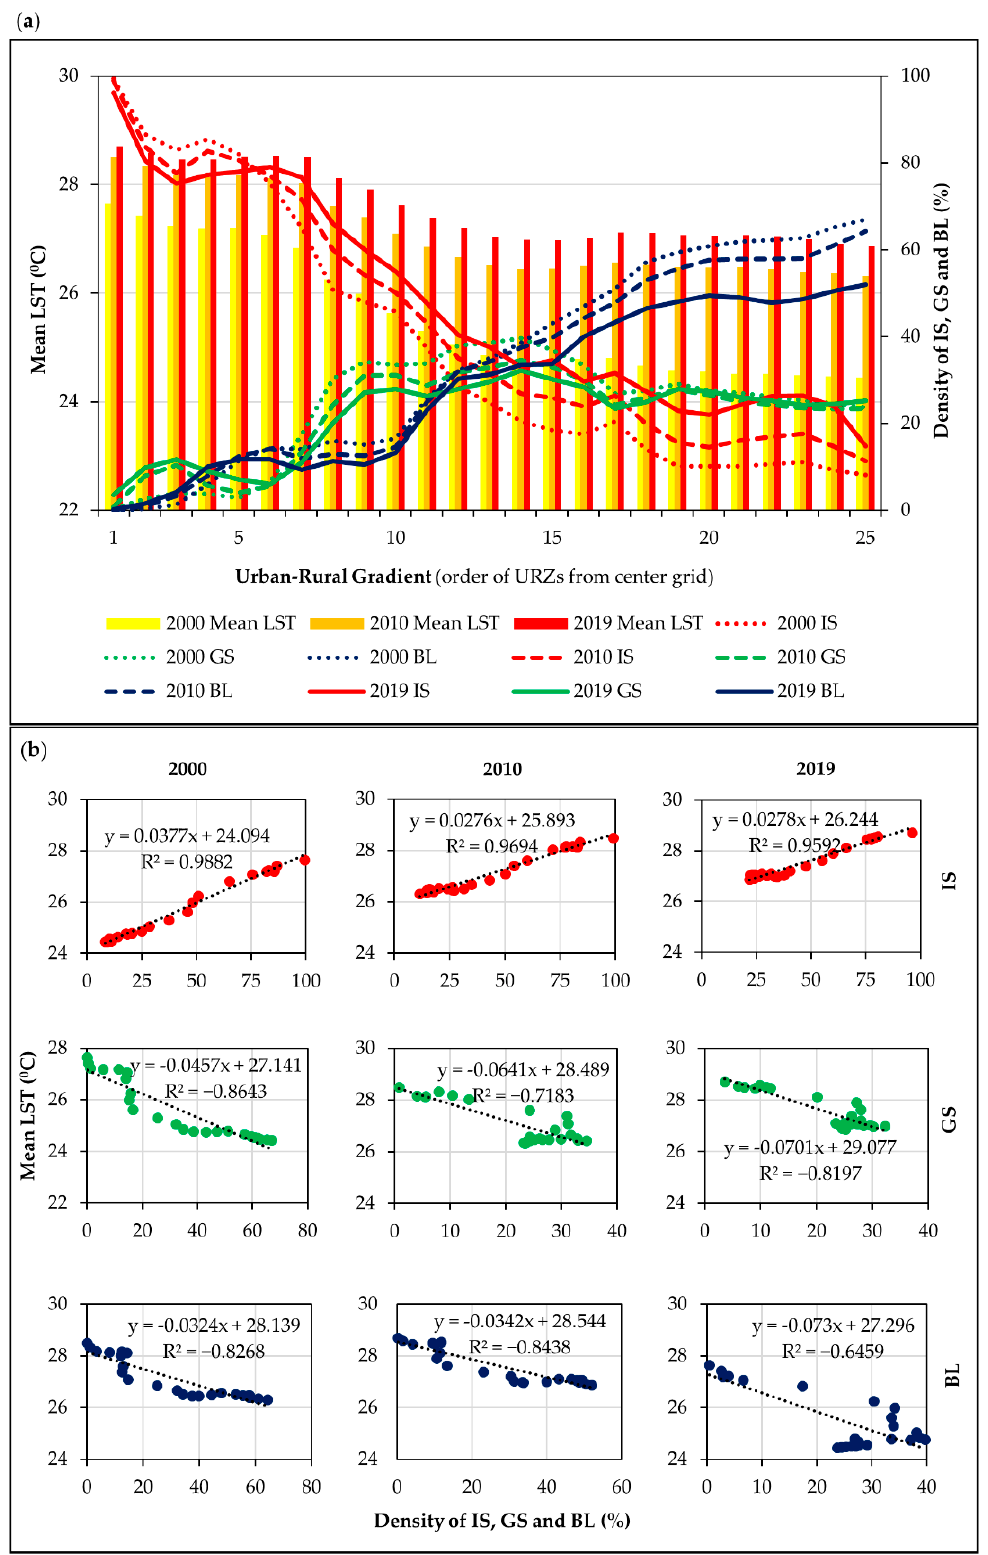
Figure 7. Urban–rural gradient analysis in the nighttime: ( a ) mean LST and density of IS, GS, and BL along the urban–rural gradient, and ( b ) statistical relationships between mean LST and density IS, GS and BL.